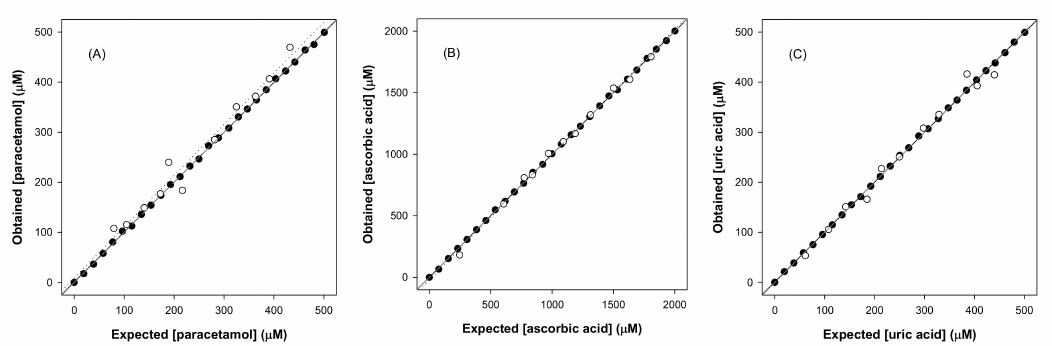
Figure 6. Modeling ability of the optimized DWT-ANN. Comparison graphs of obtained vs. expected concentrations for ( A ) paracetamol, ( B ) ascorbic acid, and ( C ) uric acid, for both the training ( • , solid line) and testing subsets ( # , dotted line). The dashed line corresponds to the ideal comparison line (y =